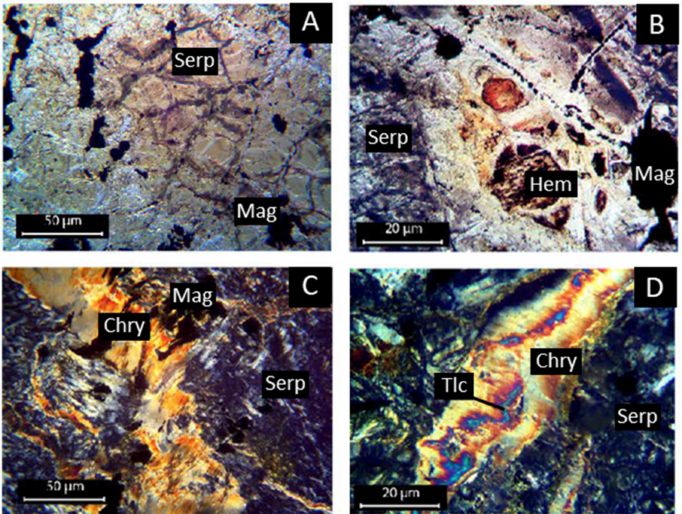
Figure 8. Photomicrographs of the serpentinite protolith. ( A ) Serpentinised olivine minerals (Serp) displaying meshwork textures. Secondary magnetite (Mag) has formed in fractures along serpen- tine grain boundaries. ( B ) Pseudomorph replacement of olivine by iron oxides (Hem = hematite). ( C ) Faulted fibrous chrysotile (Chry) veins and deformed secondary magnetite crystals suggesting local tectonic activity. ( D ) Talc (Tlc) replacement of serpentine minerals within chrysotile veins.